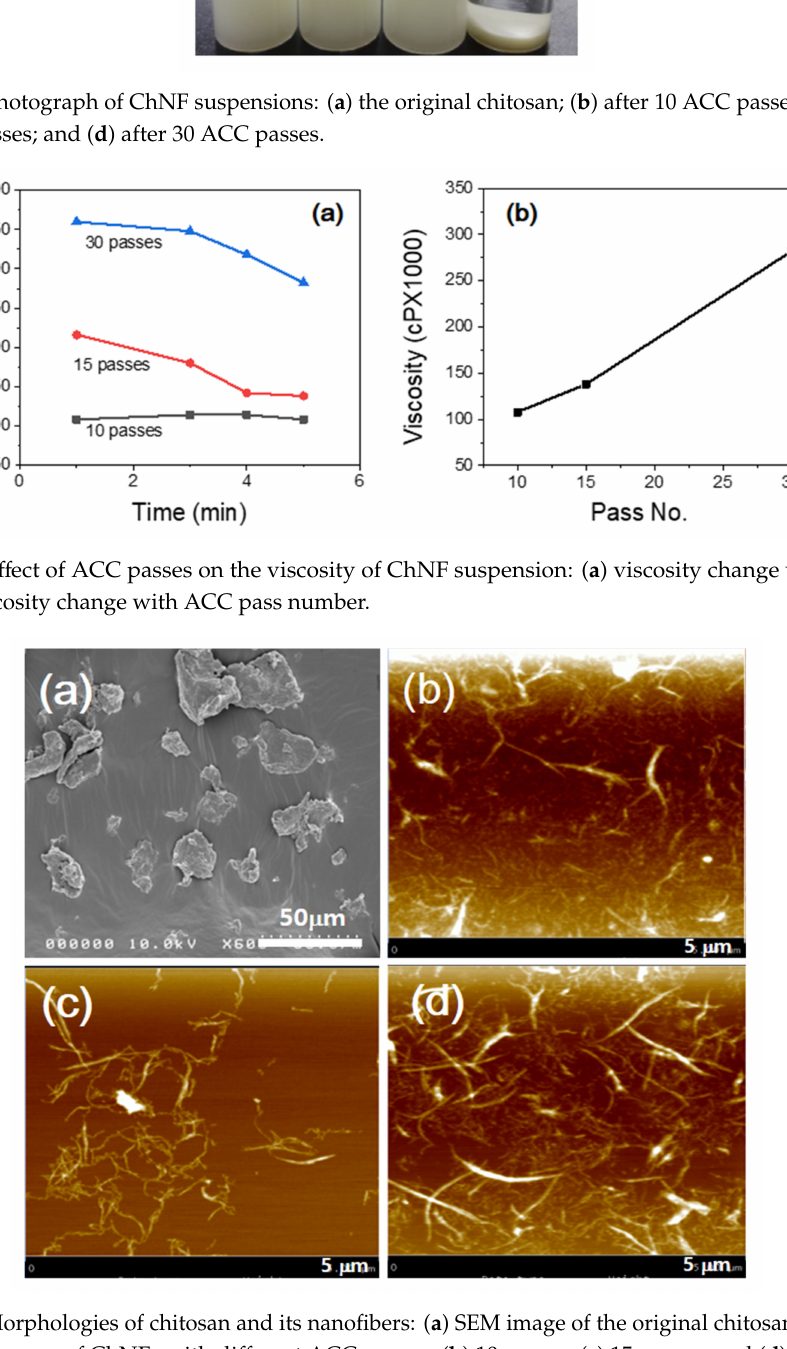
Figure 3. Morphologies of chitosan and its nanofibers: ( a ) SEM image of the original chitosan particles; and AFM images of ChNFs with di ff erent ACC passes: ( b ) 10 passes; ( c ) 15 passes; and ( d ) 30 passes (AFM images are in 5 µ m × 5 µ